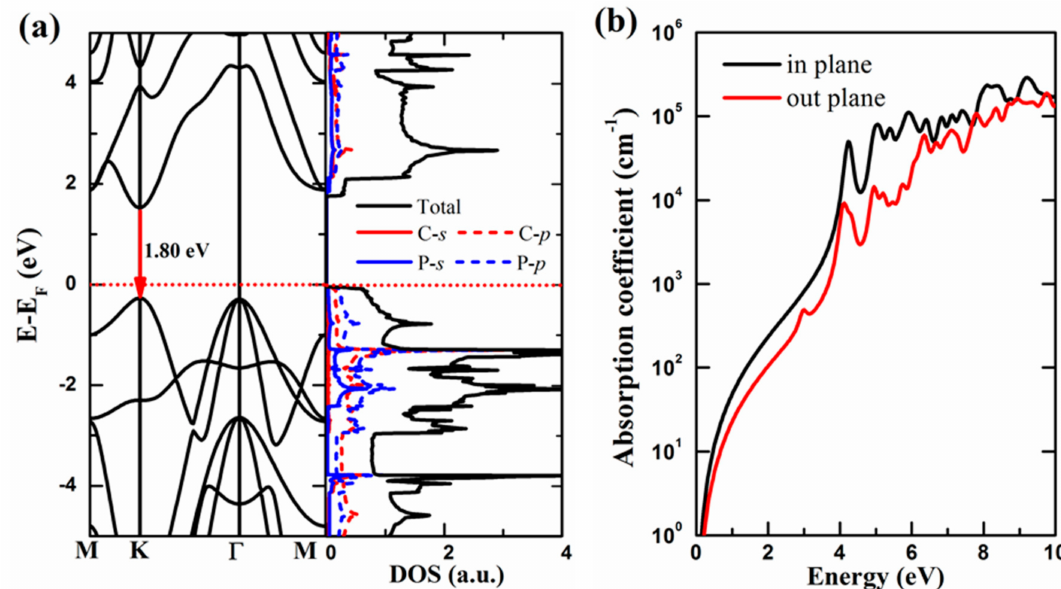
Figure 2. ( a ) Electronic structures (band structures and projected density of states (PDOS)), and ( b ) optical absorption coefficients of the GaSe-like 2D PC. In panel ( a ), the Fermi level is set to